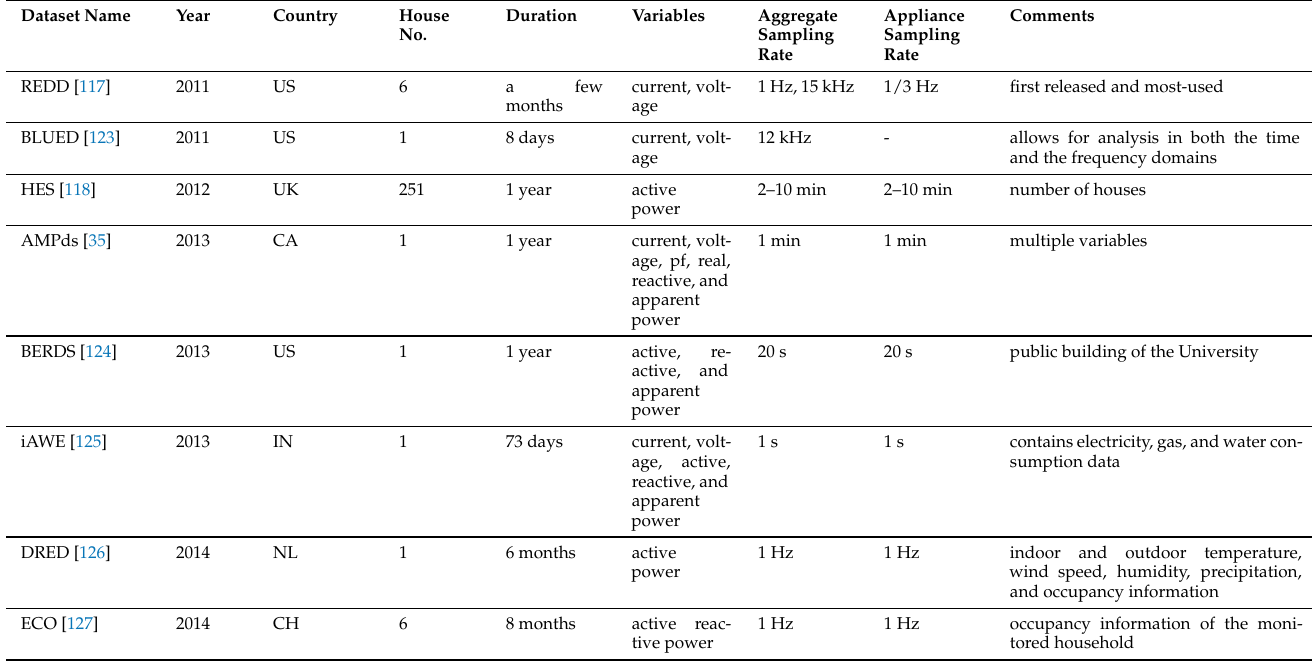
Table 2. An overview of NILM datasets. The table summarizes the year of the release for each dataset, the number of houses included, as well as the duration of the dataset and the measured variables. Furthermore, the last common refers to notes worth mentioning for each